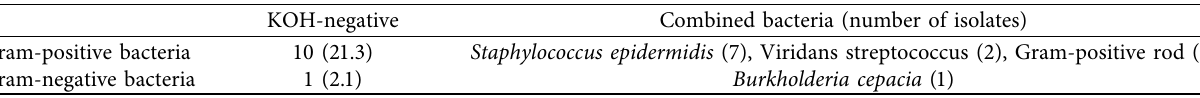
Table 5: Combined bacterial distribution in the KOH-negative group.